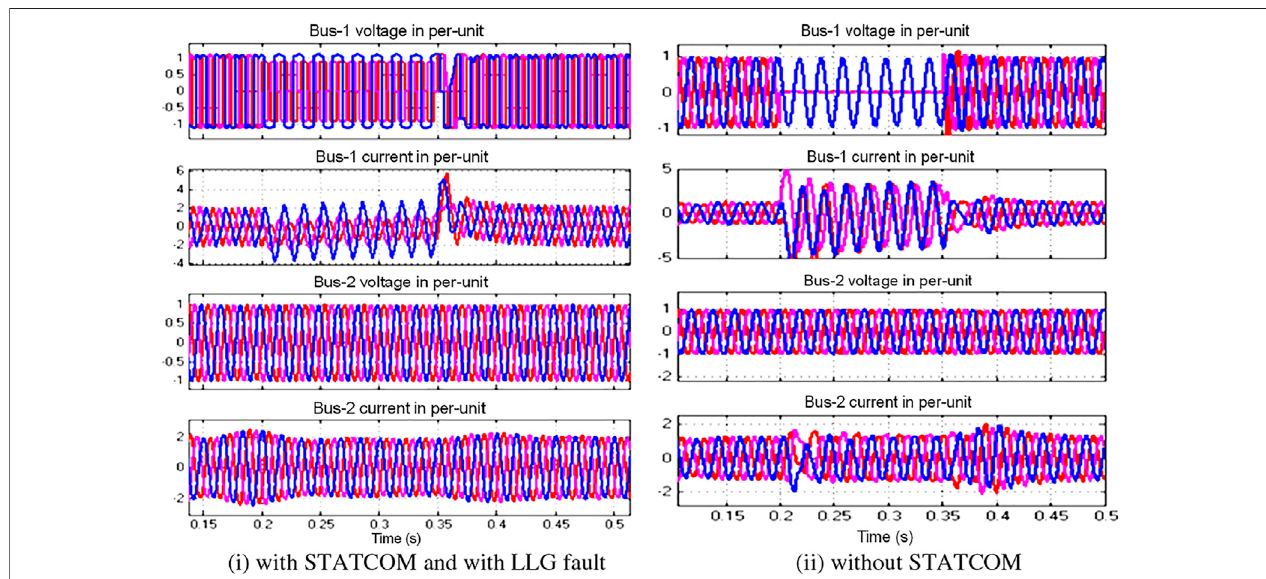
FIGURE 9 | HVDC sending-end (bus 1) and receiving-end side (bus 2) AC voltage and current. (i) With STATCOM and with LLG fault. (ii) Without STATCOM.